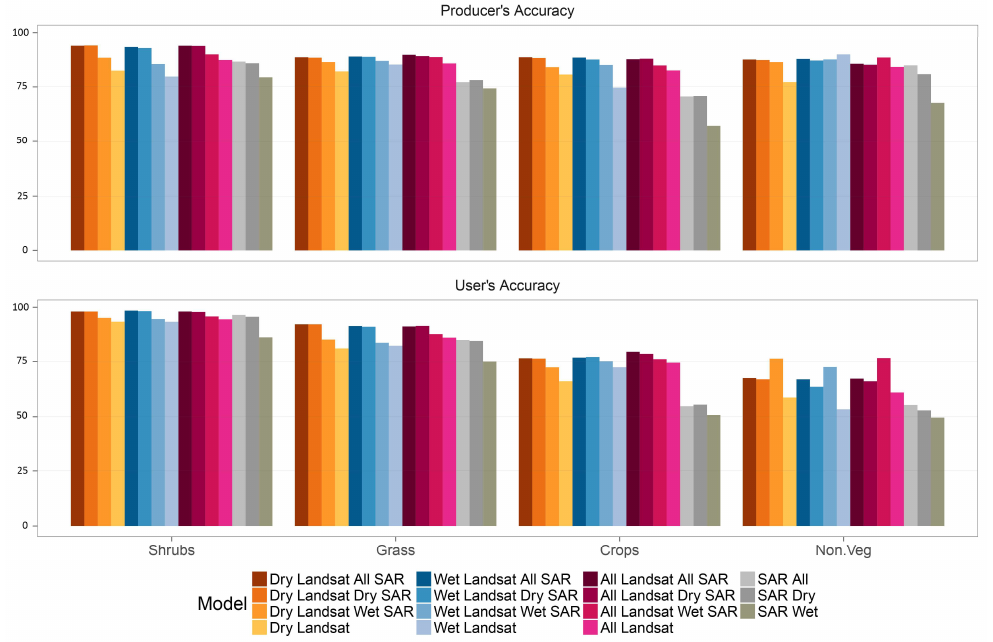
Figure 6. The class-level accuracy statistics for the 15 models tested.